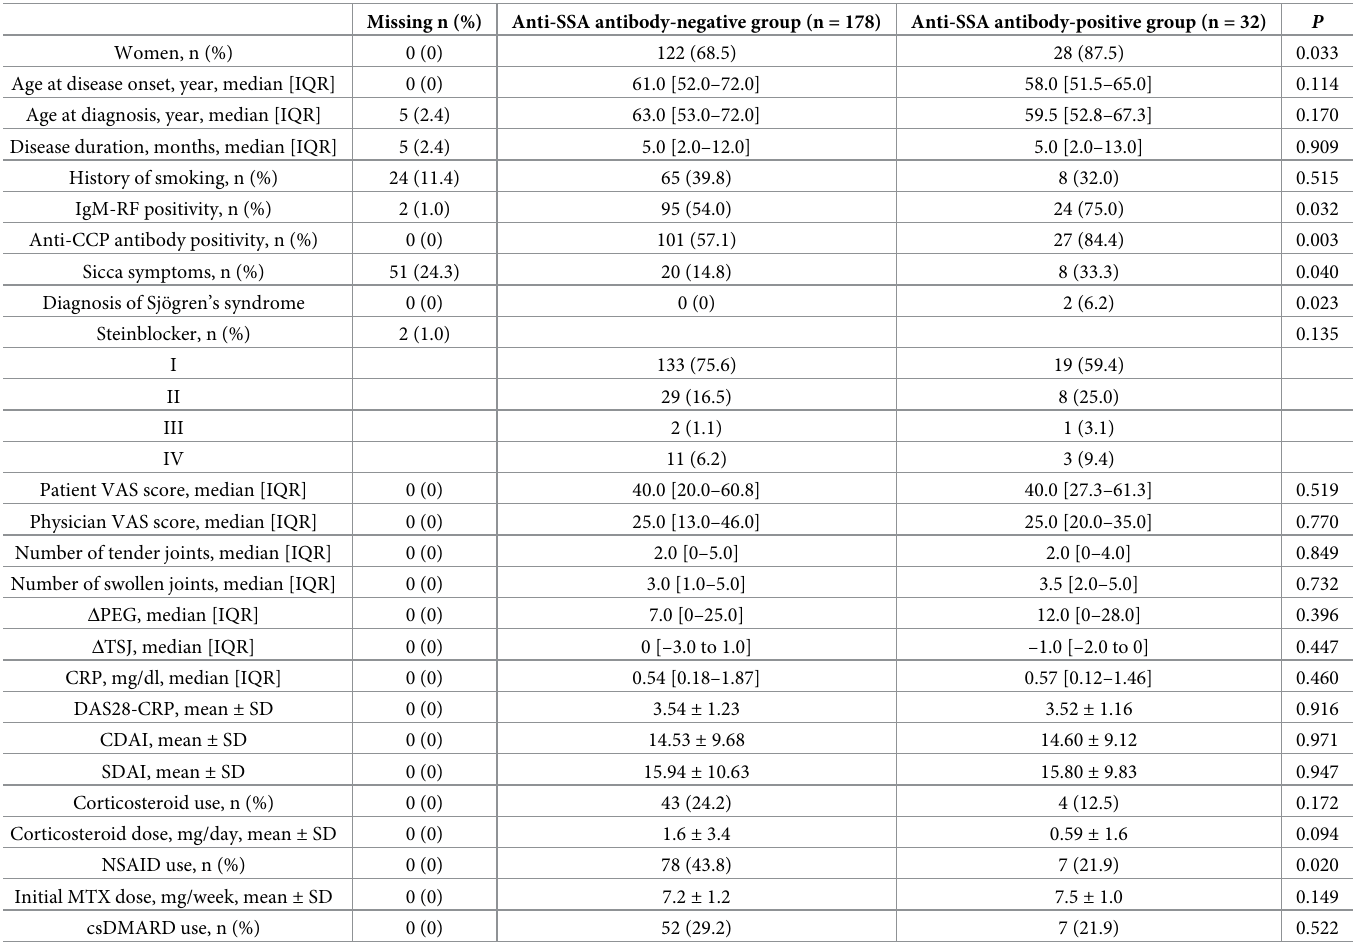
Table 1. Patient characteristics at